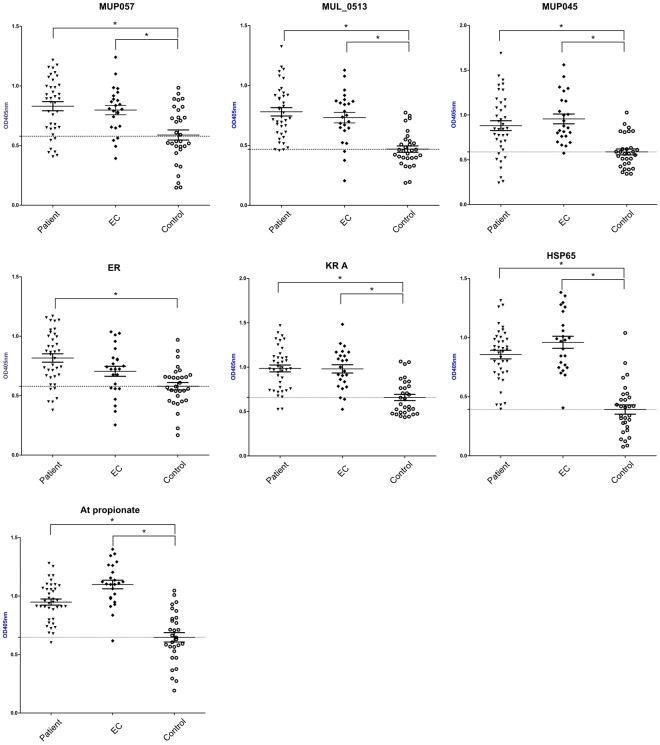
ELISA results for seven M. ulcerans proteins capable of discriminating between patients and controls.Comparison of patient, endemic control (EC) and non-endemic control sera reactivity to seven M. ulcerans antigens that showed an ability to discriminate between patient and control sera. Mean OD405nm readings for each group and standard error of the mean are shown. The horizontal dotted line in each figure represents the mean OD405nm reading of the control group. * = p<0.05.